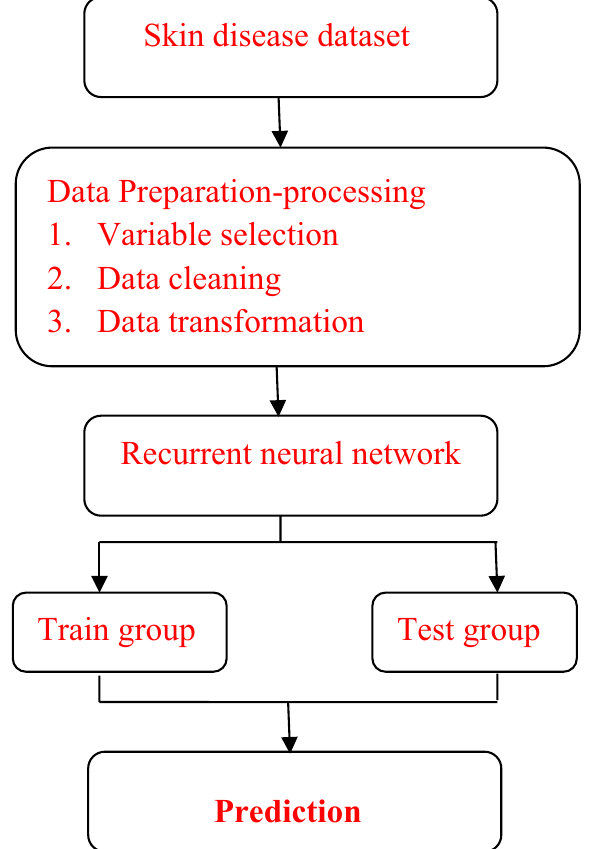
Figure 1. Methodological approach for skin